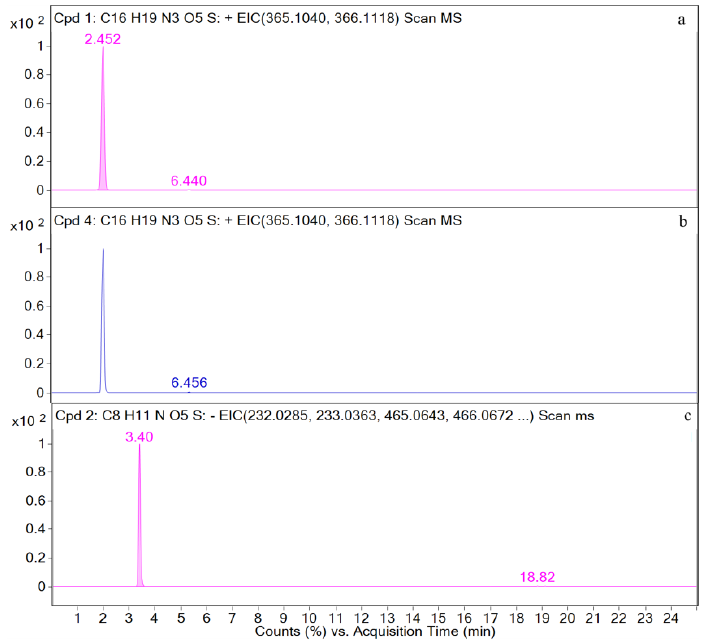
Figure 9. Ion chromatograms of kidney samples. ( a ) M1; ( b ) M3; ( c ) M4. M1, M3, and M4 are detected in the plasma samples. The EIC and TIC for the plasma sample are shown in Figure 10 and Figure A3 in the Appendix A, respectively.